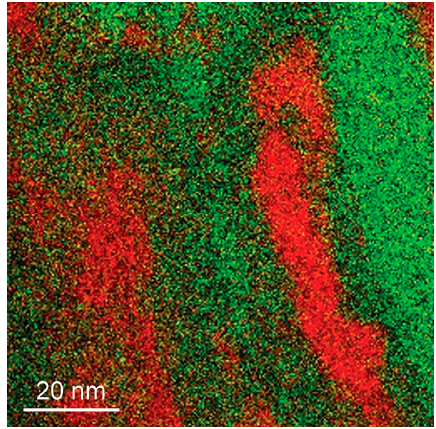
Figure 15. Fragment of the map of element distribution in the sample after HPT to N = 6: Cu and Nb are displayed in red and green colors, respectively.